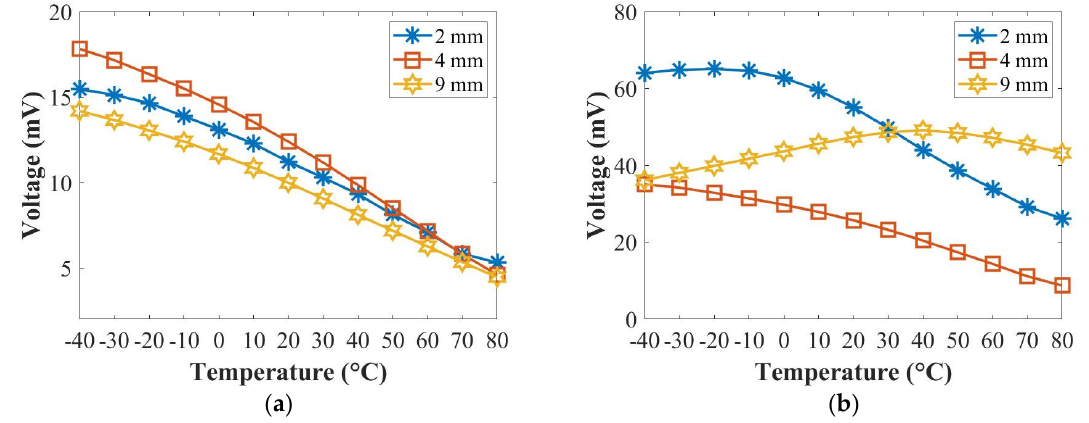
Figure 8. Relationships of the temperature with the peak amplitude at 50 kHz ( a ) and 250 kHz ( b ).